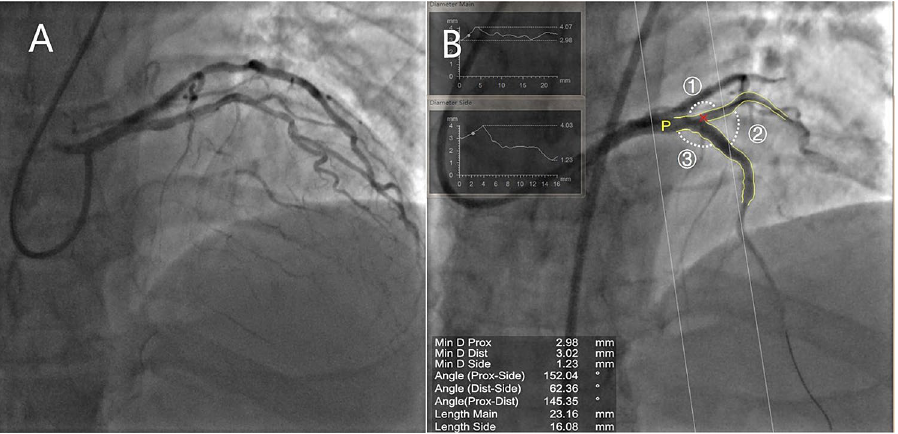
Figure 2. Coronary angiogram and quantitative coronary analysis. ( A ) Chronic total occlusion in the left anterior descending artery with a significant diagonal branch in the proximal cap. ( B ) The result of two- dimensional quantitative coronary analysis after recanalization. ① Denotes the Prox-Side angle (between the proximal MV and SB); ② denotes the Dist-Side angle (between the distal MV and SB); and ③ denotes the Prox- Dist angle (between the proximal and distal MV. Min D Prox, minimum diameter of the proximal part of the segment; Min D Dist, minimum diameter of the distal part of the segment; Min D Side, minimum diameter of the SB; MV, main vessel; SB, side